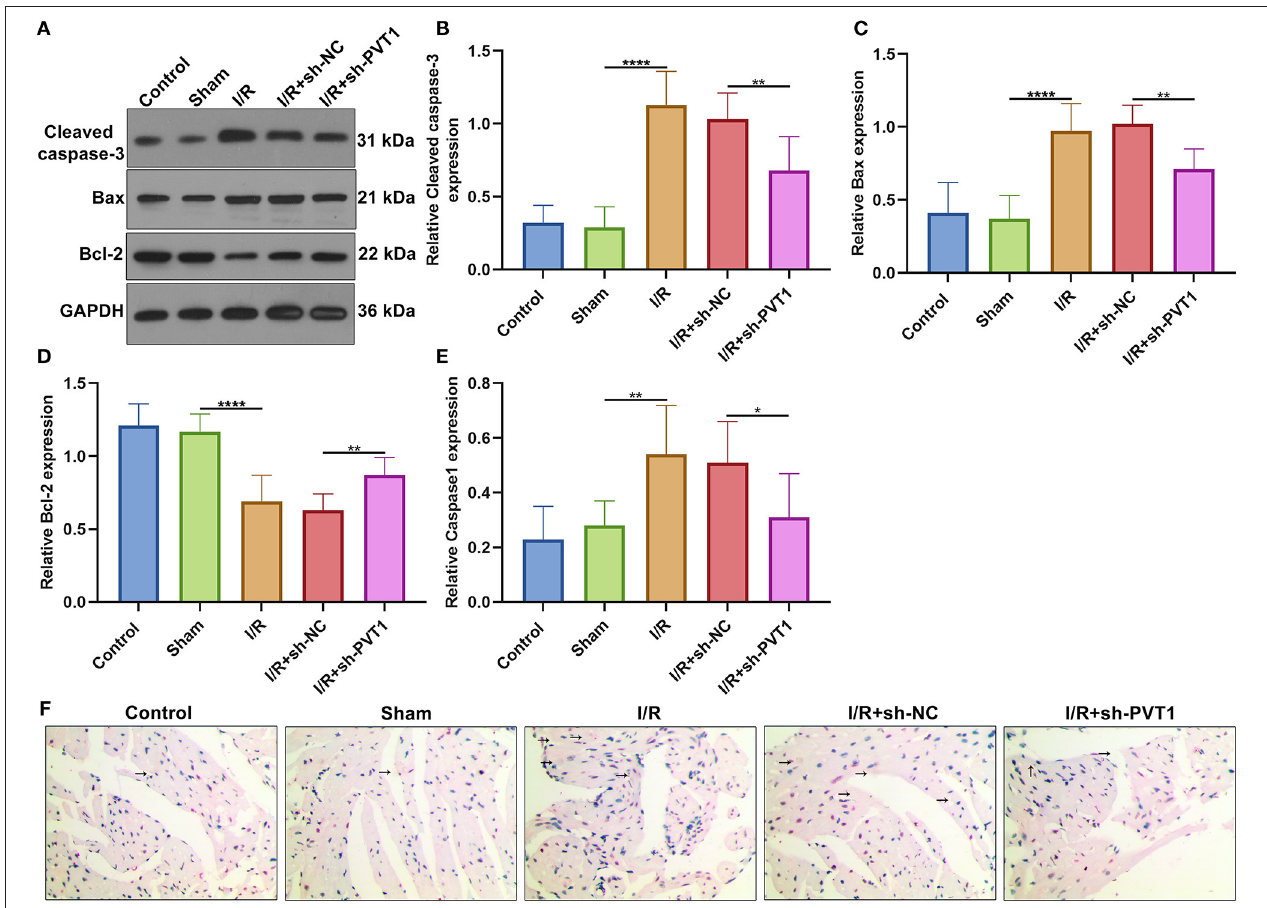
FIGURE 5 | LncRNA PVT1 knockdown suppresses I/R-induced apoptosis and Caspase1 involving pyroptosis in myocardial tissues. (A–D) Western blot of the expression of (B) Cleaved caspase-3, (C) Bax, and (D) Bcl-2 proteins in myocardial tissues of five groups: control, sham, I/R, I/R + sh-NC, and I/R + sh-PVT1 groups. Mice in the I/R + sh-NC and I/R + sh-PVT1 groups were injected by 10 µ L sh-NC or sh-PVT1 via Lipofectamine 2000 reagent. After 48h, myocardial I/R model was constructed. No treatment was done for mice in the control group. The chest of mice in the sham operation group was only opened, but was threaded the corresponding part without ligating the LAD. There were 10 mice in each group. (E,F) Immunohistochemistry of the expression of Caspase1 protein in myocardial tissues of above groups. Bar = 100 µ m. Arrow highlights the positive staining of Caspase1. * p < 0.05; ** p < 0.01; **** p <